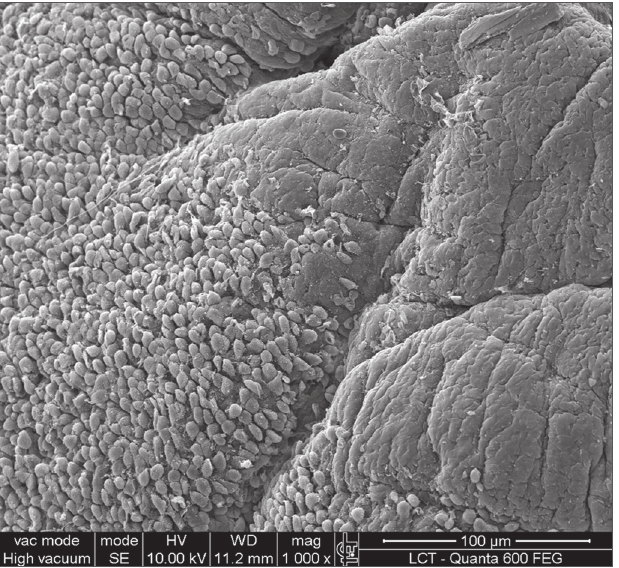
Figura 6. Epitélio cilíndrico não-ciliado ao lado de metaplasia esca- mosa